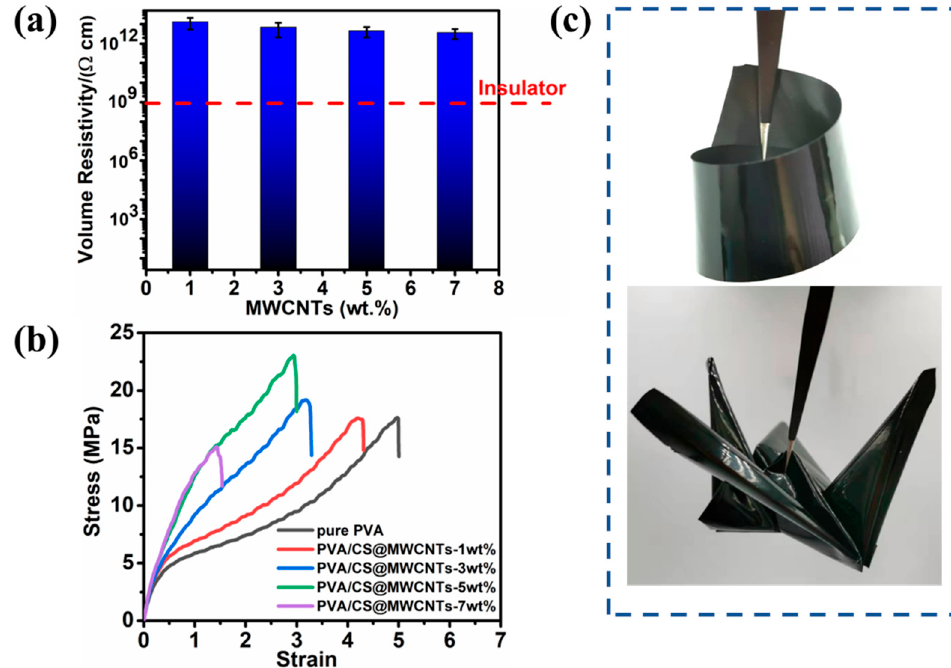
Figure 8. ( a ) Volume resistivity of PVA/CS@MWCNTs composite films varied with the loading of MWCNTs; ( b ) Mechanical property of pure PVA and PVA/CS@MWCNTs composite films with different content of MWCNTs; ( c ) PVA/CS@MWCNTs composite film with a content of 5 wt% MWCNTs folded into different shapes, showing excellent flexibility.